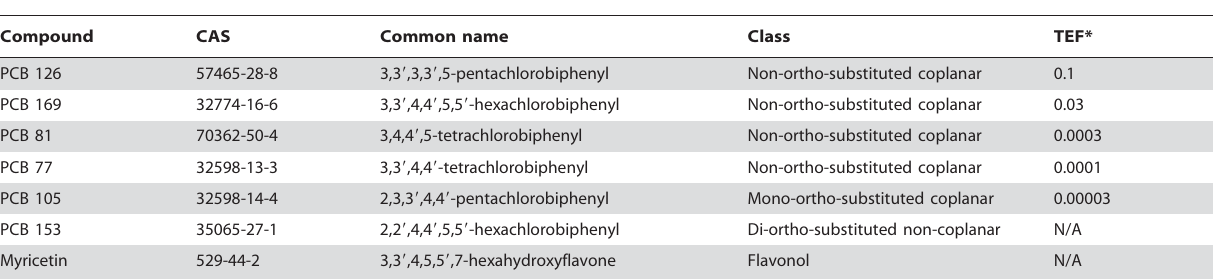
Table 1. Summary of compounds.